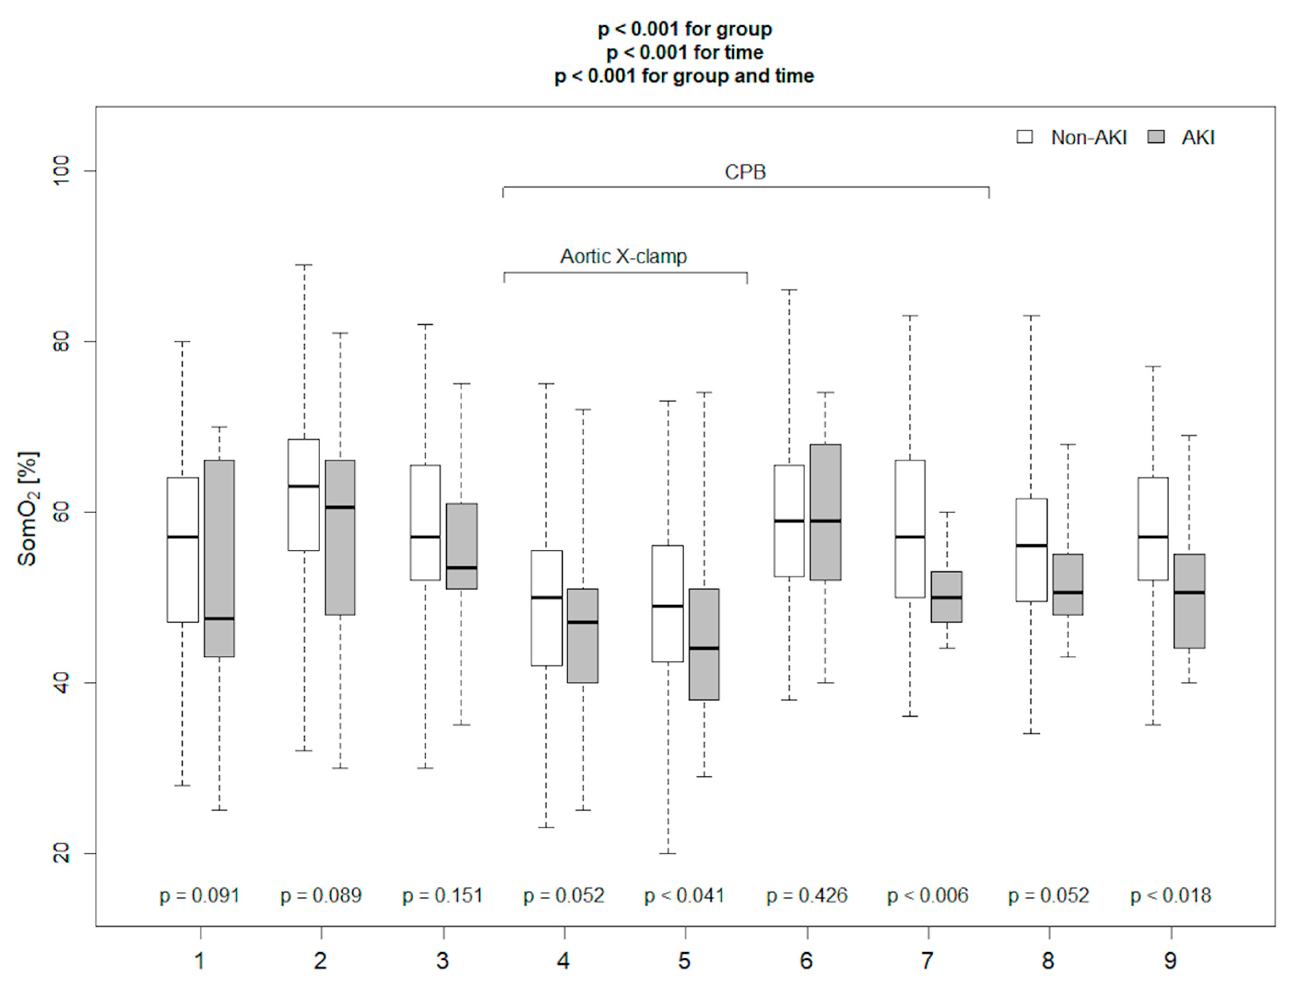
Figure 2. NIRS muscle saturation measured in the operation room in AKI and non-AKI patients at time-points specified in methods ( p values for comparison between AKI and non-AKI patients at specified time points. {1}—before anaesthesia induction, {2}—directly before skin incision, {3}—after sternum opening, {4}—20 min after aortic cross-clamping, {5}—40 min after aortic cross-clamping, {6}—20 min after aortic cross-clamp removal, {7}—20 min after weaning from CPB, {8}—40 min after separation from CPB, {9}—60 min after separation from CPB).